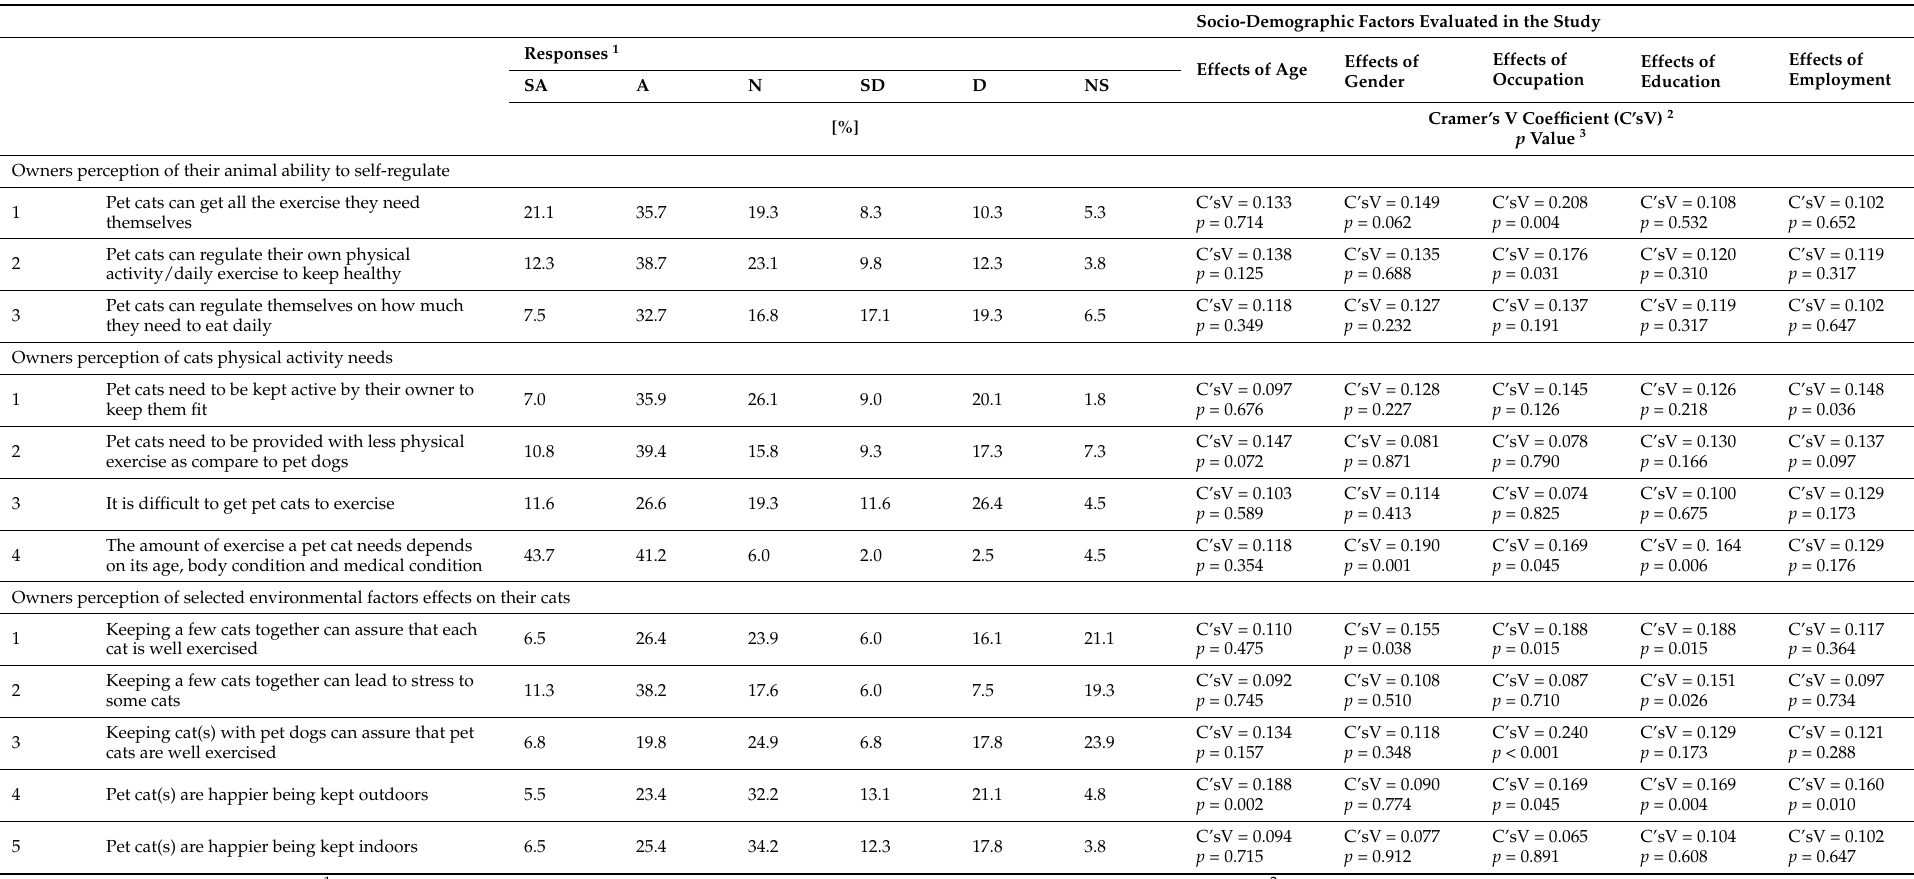
Table 7. Owners’ perceptions of their cats’ needs and satisfaction. A full set of cross-tabulated results is shown in Supplementary Materials (Table